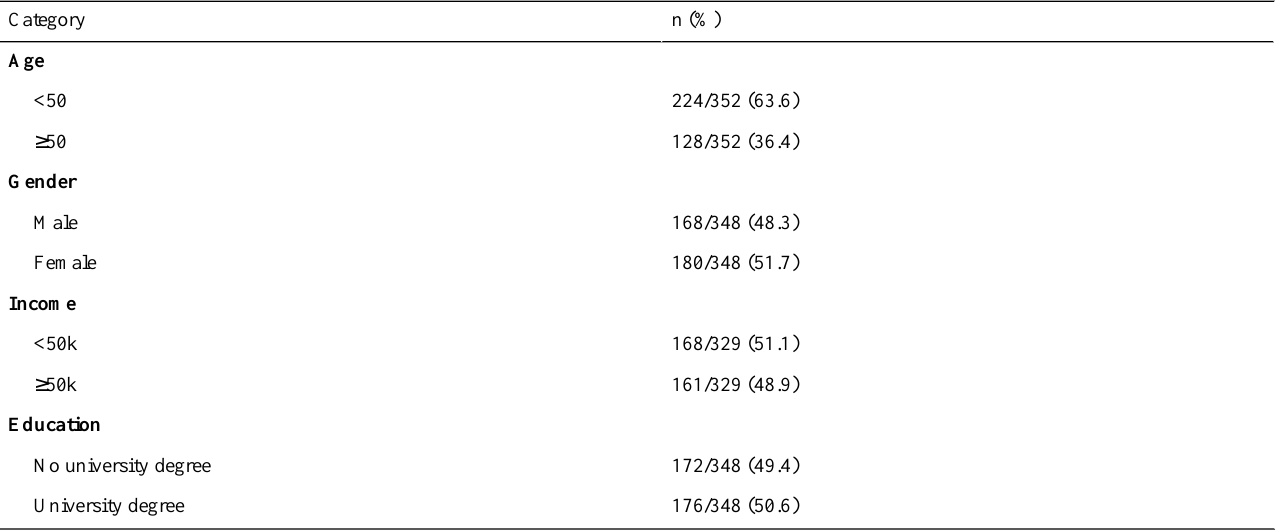
Table 1. Demographic information of electronic feedback users. a